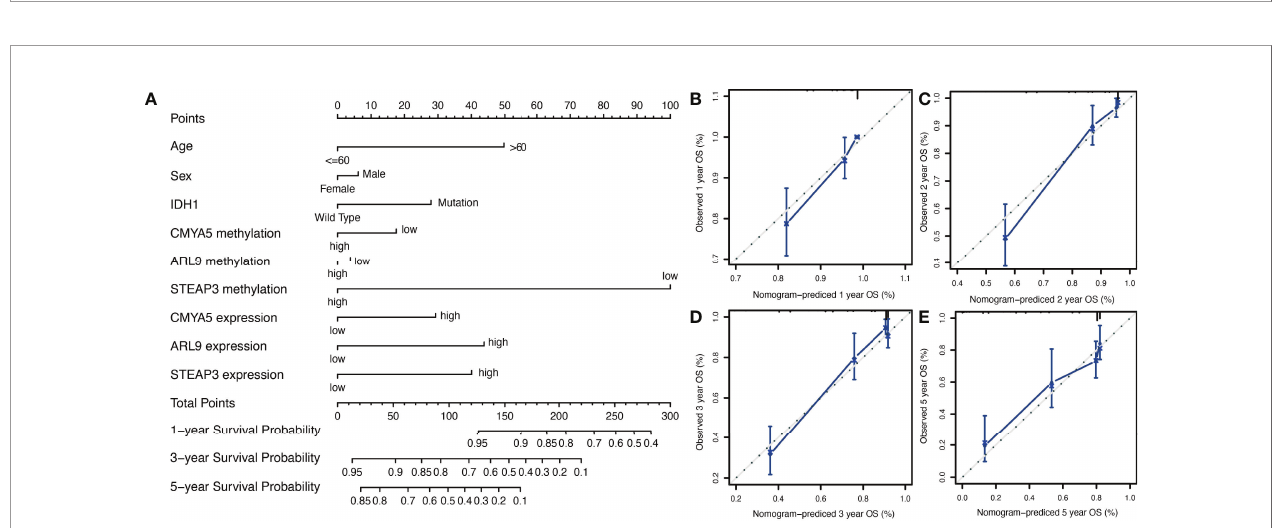
FIGURE 6 | Nomogram construction and validation. (A) Prognostic nomogram to predict 1-, 3-, and 5-year survival probability for patients with LGG. (B – E) Calibration curves of the nomogram for predicting the probability of OS at 1-, 2-, 3-, and 5-years. The x-axis represents nomogram-predicted probabilities; the y-axis represents actual survival rates of patients.